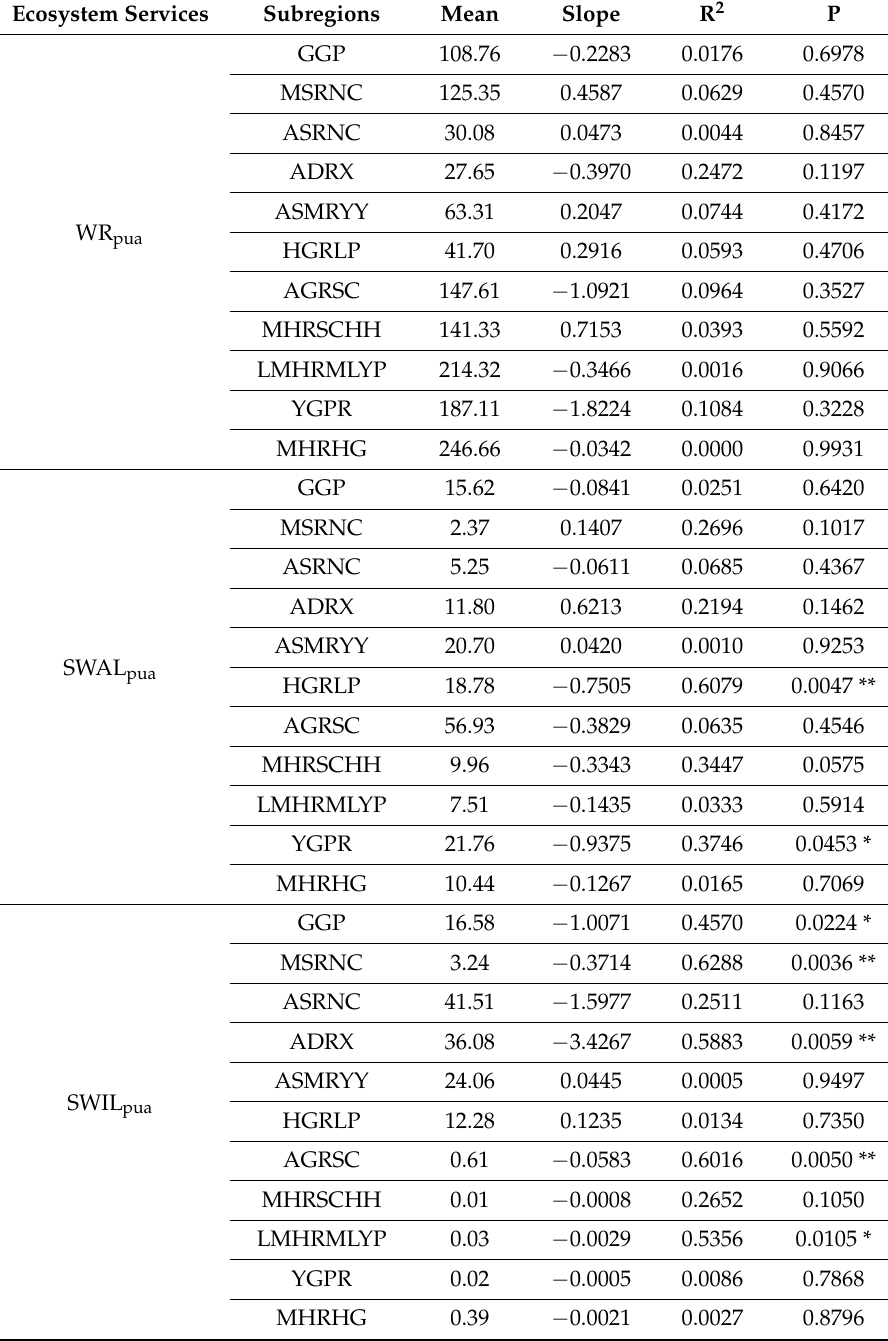
Table 6. Statistical parameters of ecosystem services indicators in the Grain for Green Program (GGP) area from 2000 to 2010. The units of the mean and slope of WR pua are 10 4 t km − 2 and 10 4 t km − 2 yr − 1 , respectively, while for both SWAL pua and SWIL pua , units are t ha and t ha yr − 1 , respectively. Ecosystem